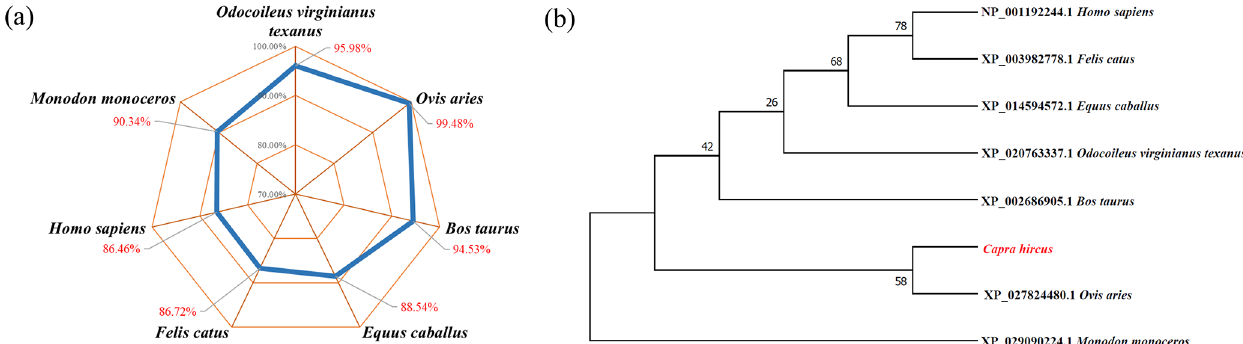
Figure 3. Analysis of amino acid sequence similarity (a) and phylogenetic tree (b) of goat STEAP4